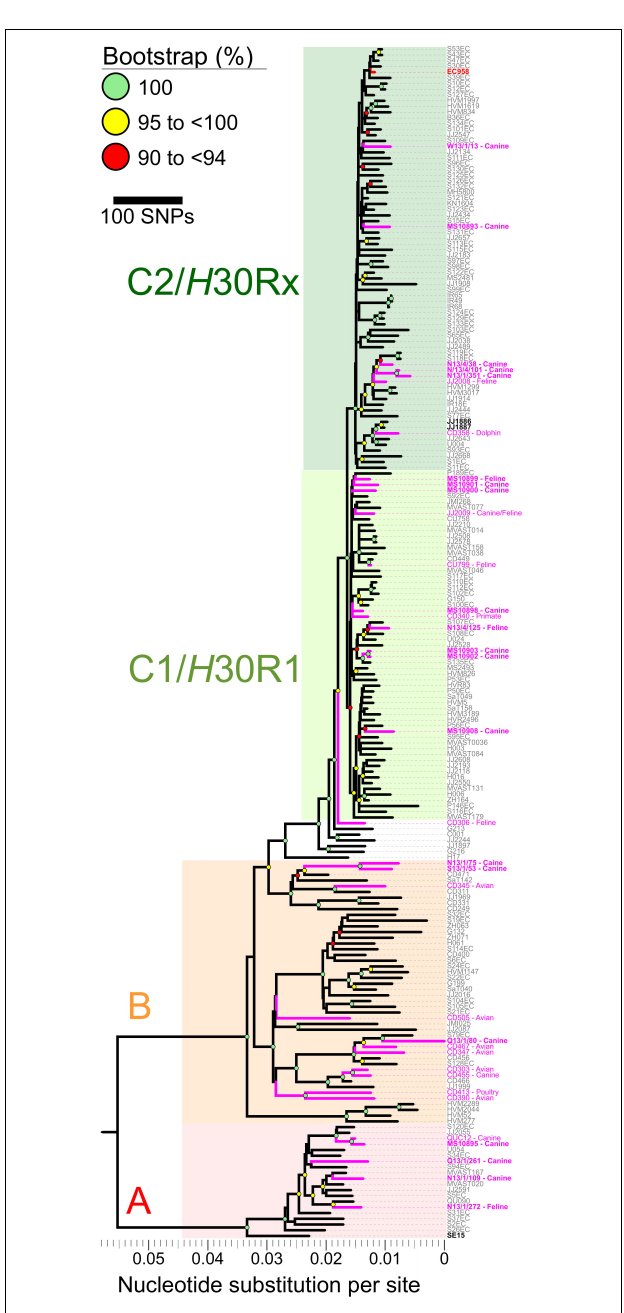
FIGURE 2 | Core-genome single nucleotide polymorphisms (SNPs) phylogeny of 208 Escherichia coli ST131 isolates from humans, cats, dogs, and other animals. The Maximum Likelihood tree was built using 7,527 non-recombinant core-genome single nucleotide polymorphisms (SNPs), as called by mapping sequencing reads to the chromosome of EC958 (GenBank: HG941718.1) with masked genomic islands and prophage regions. Colored groupings represent three labeled clades. H 41/A (red), H 22/B (orange), and C1/C2/ H 30 (green). Branch lengths are drawn to scale and represent the number of nucleotide substitutions per site (scalebar) or number of SNPs (key). Pink labels represent isolates collected from animals. Boldface pink labels with an asterisk represent the 20 cat and dog-source ST131 isolates sequenced as part of this study (11 from the Saputra et al. (2017) study, and nine [indicated by the MS prefix] from the Platell et al. (2010)